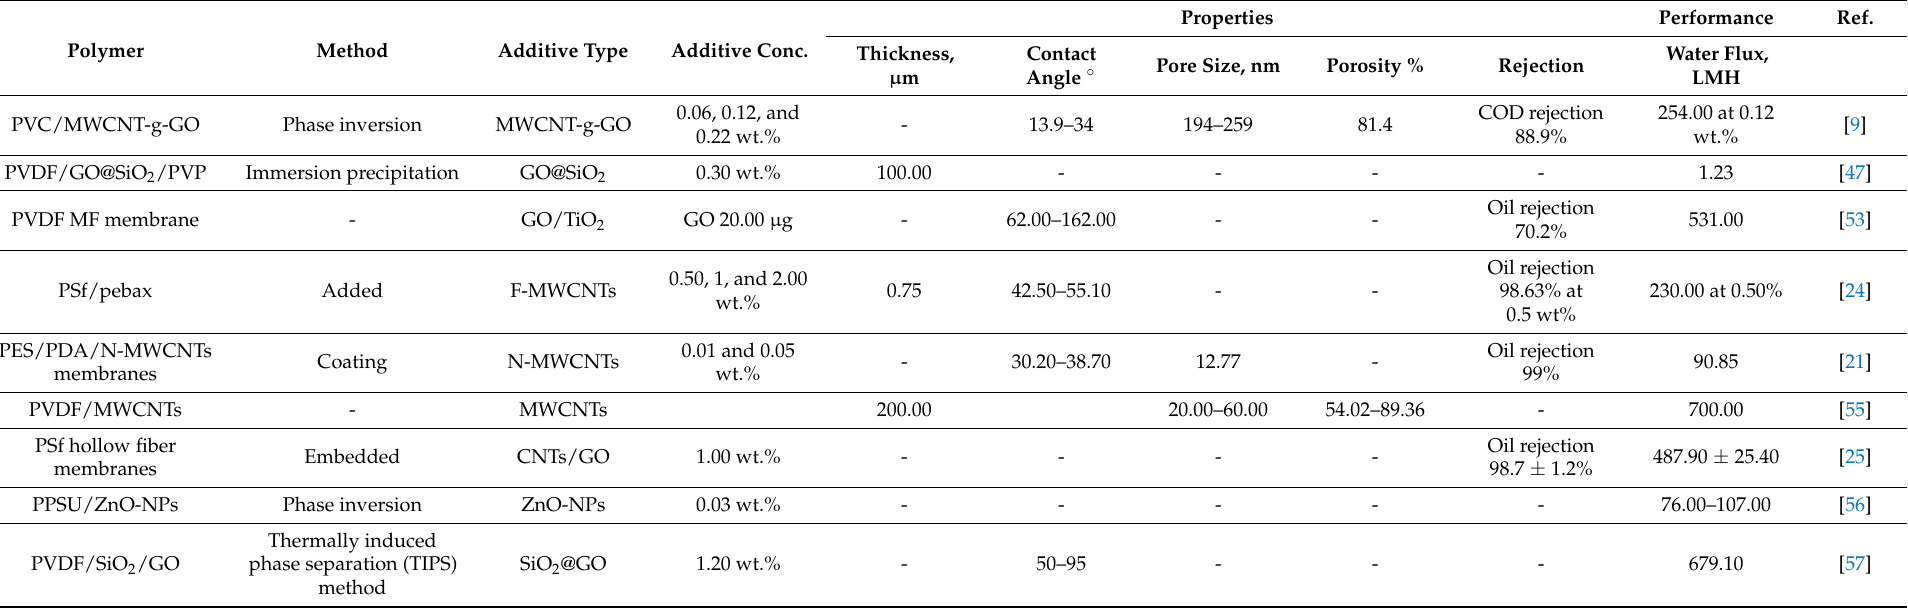
Table 6. Examples of research on the type of nanoparticles (NPs) and effect on the membrane